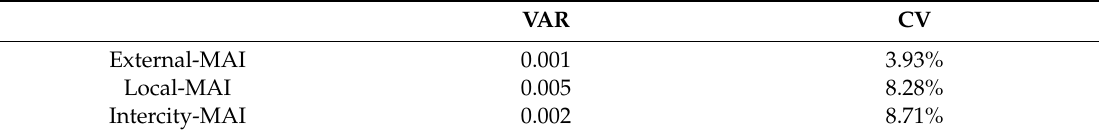
Table 9. The variance (VAR) and coe ffi cient of variation (CV) of di ff erent types of MAI. VAR